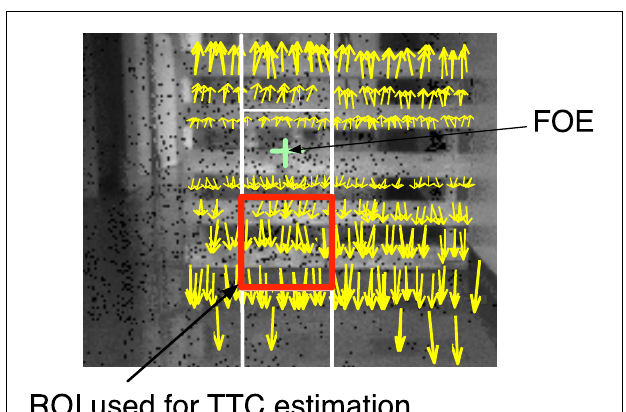
FIGURE 10 | TTC computation: the yellow arrows represent the motion flow vectors obtained during a time period of 1ms. These flow vectors are superimposed over a corresponding image of the scene (realized using the PWM grayscale events). In order to enhance the readability of the Figure, only 10% vectors with high strengths and orientations close to ± π / 2 have been draw. The red square corresponds to the ROI where the measure of TTC is